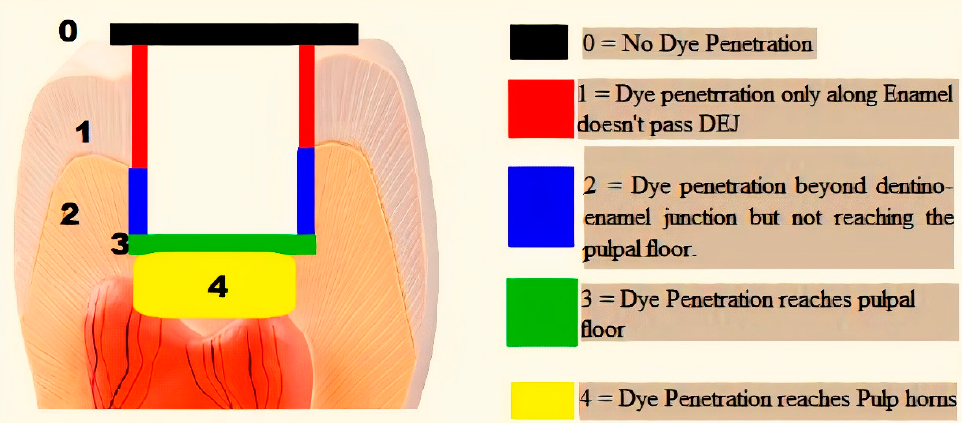
Figure 4. Schematic diagram representing the used scoring system of marginal leakage.